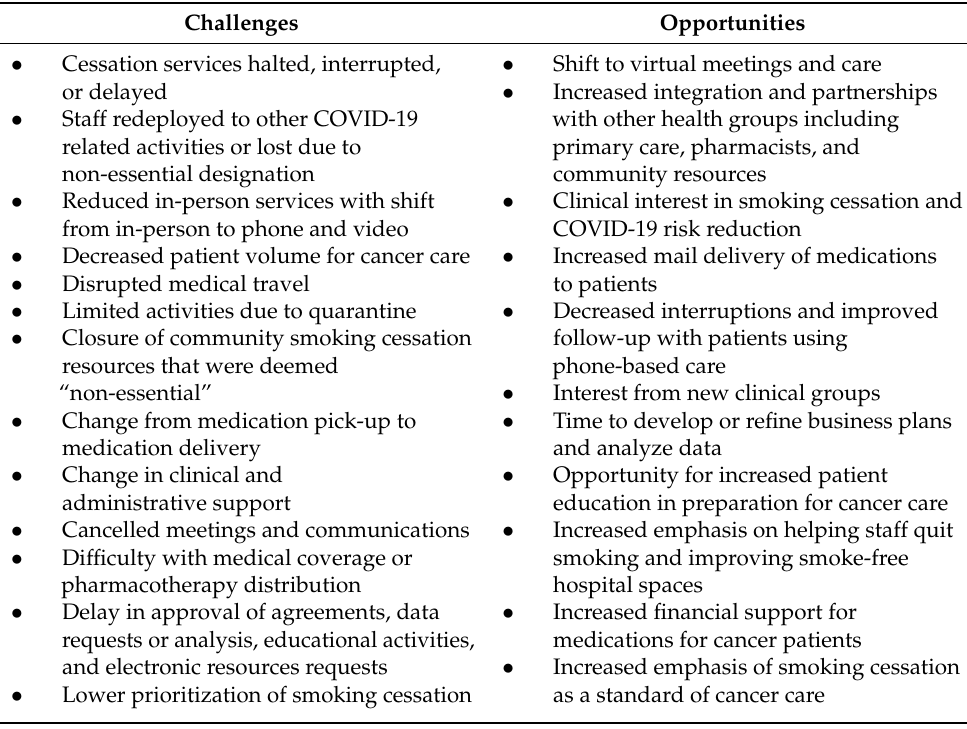
Table 2. Challenges and opportunities reported by jurisdictions during the COVID-19 pandemic. Challenges